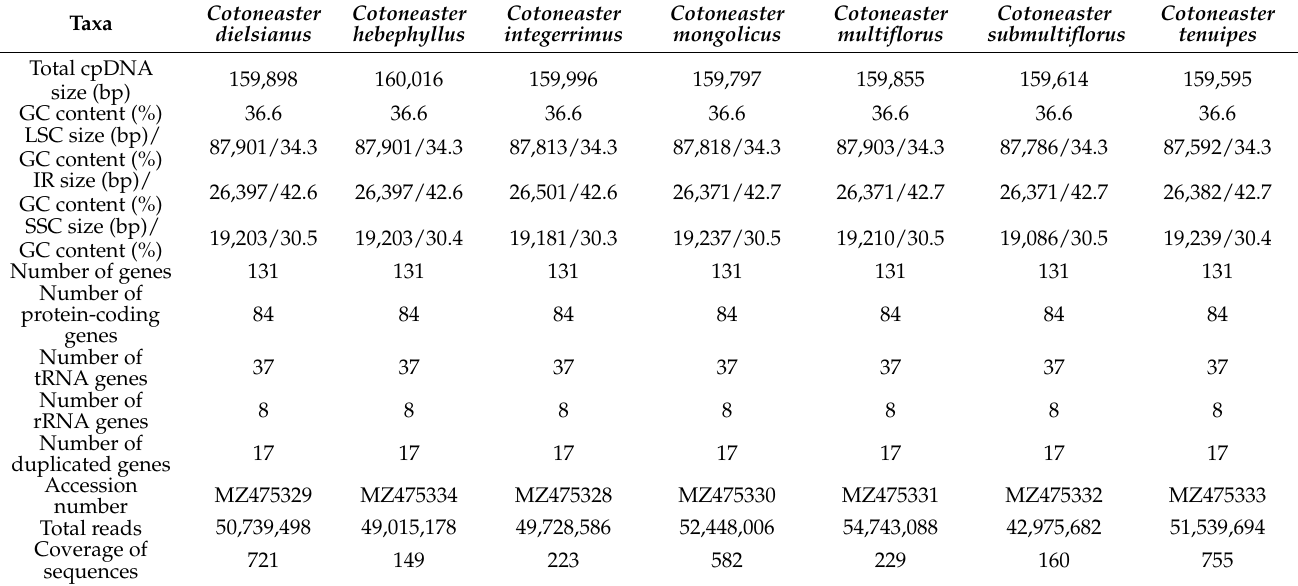
Table 1. Summary of the characteristics of the seven Cotoneaster chloroplast genomes analyzed in this